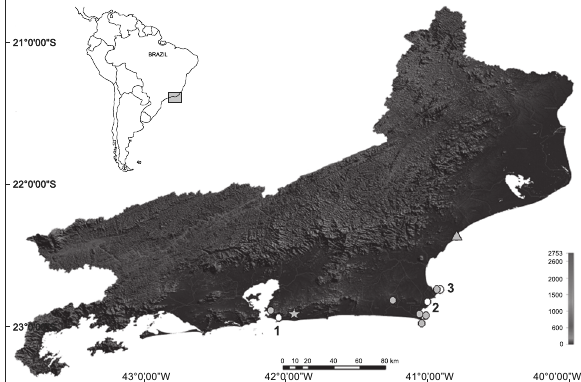
Figure 1. Geographic distribution of Scinax littoreus . ( (cid:144) ) Bambui, Municipality of Maricá (type-locality); ( (cid:122) ) examined specimens; ( (cid:83) ) literature record (P EIXOTO 1988); ( (cid:123) ) analyzed populations: 1) Pedra de Itacoatiara, Municipality of Niterói; 2) Praia do Peró, Muncipality of Cabo Frio; 3) Praia do Forno, Municipality of